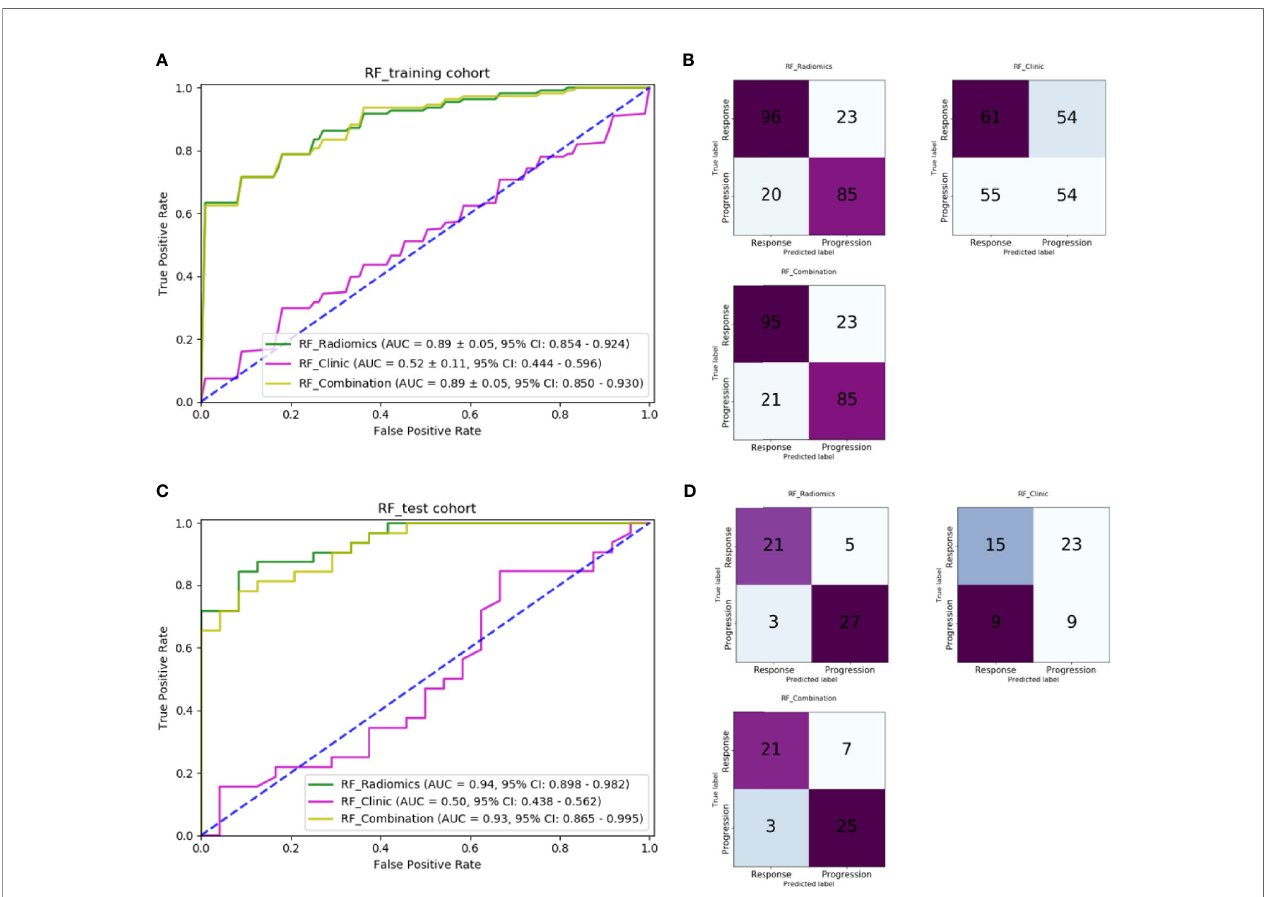
FIGURE 6 | Comparison of machine-learning models: (A) ROC curves for different machine-learning models in the training cohort; (B) Confusion matrix of different machine-learning models in the training cohort; (C) ROC curves for different machine-learning models in the independent test cohort; (D) Confusion matrix of different machine-learning models in the independent test